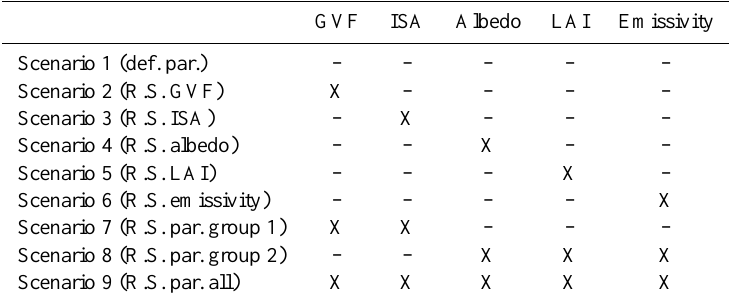
Table 1. Model scenarios (1–9) and the incorporated remotely sensed parameter sets. GVF ISA Albedo LAI Scenario 1 (def.